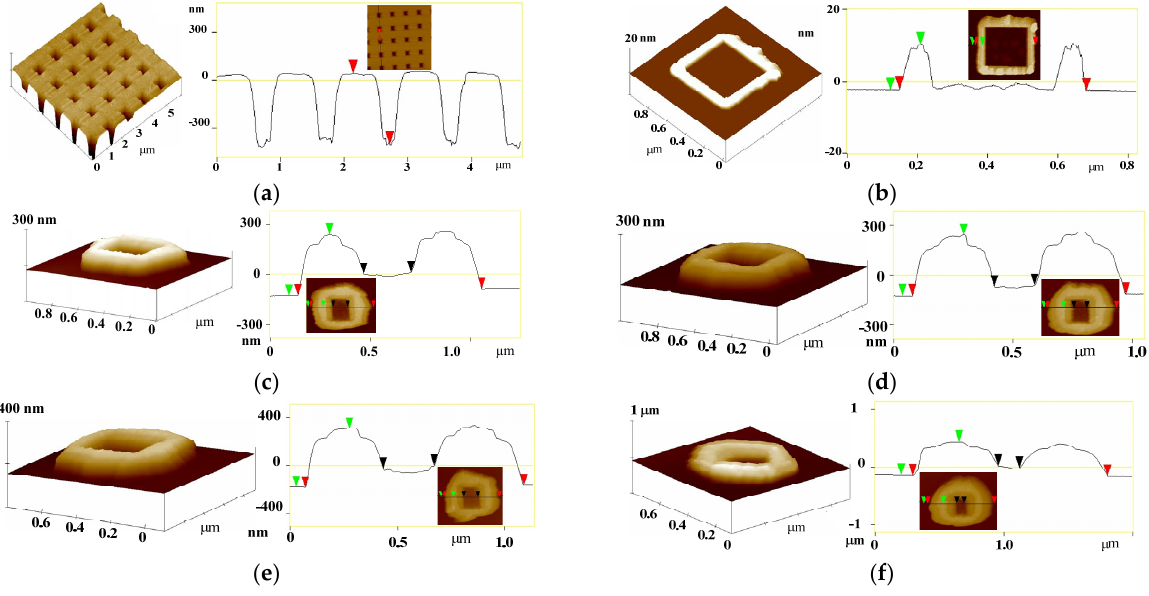
Figure 2. Morphology analysis of the ( a ) polymer template, ( b ) 3EP assembly, ( c ) PMAA brush, ( d ) SPHR, ( e ) abY ‐ modified SPHR, and ( f ) abY ‐ anchored SPHR after coupling with agY at 150 pg mL − 1 by AFM.